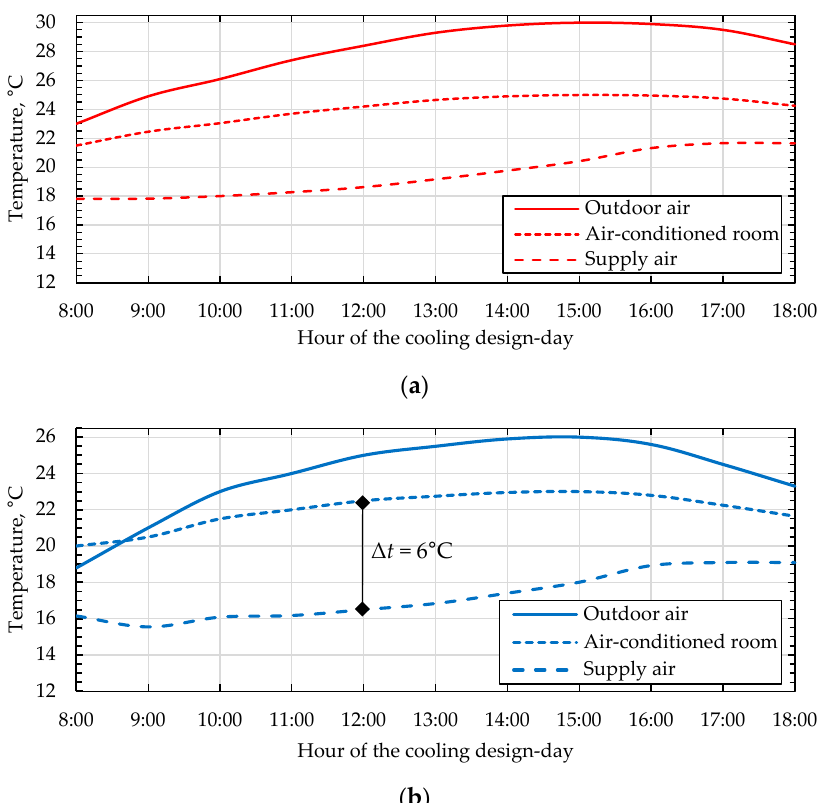
Figure 6. The key temperature values for the cooling design-day: ( a ) 24 August; ( b ) 22 September.